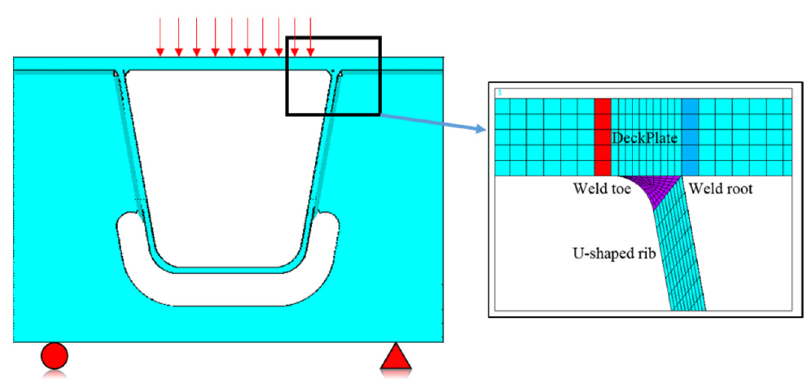
Figure 18. The constraint, fatigue load and component of the OSB in the partial model. Table 2. Overall schemes and geometric parameters of OSBD.